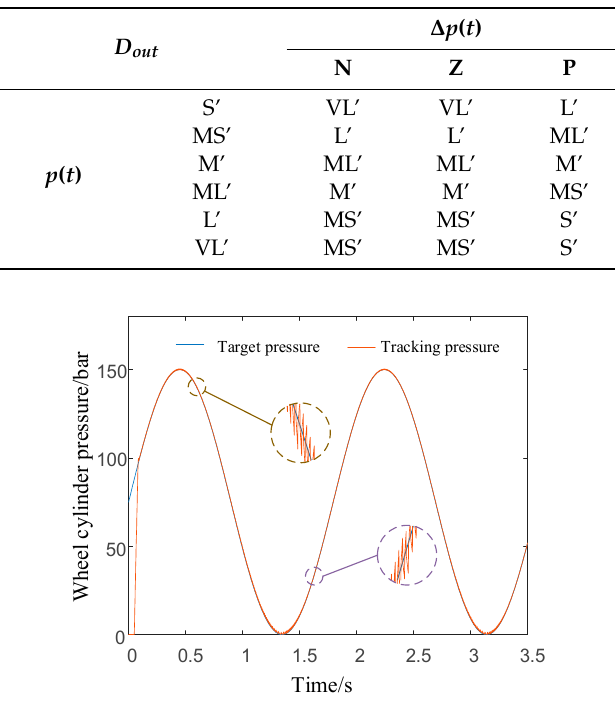
Table 6. The fuzzy control rules of the outlet valve.